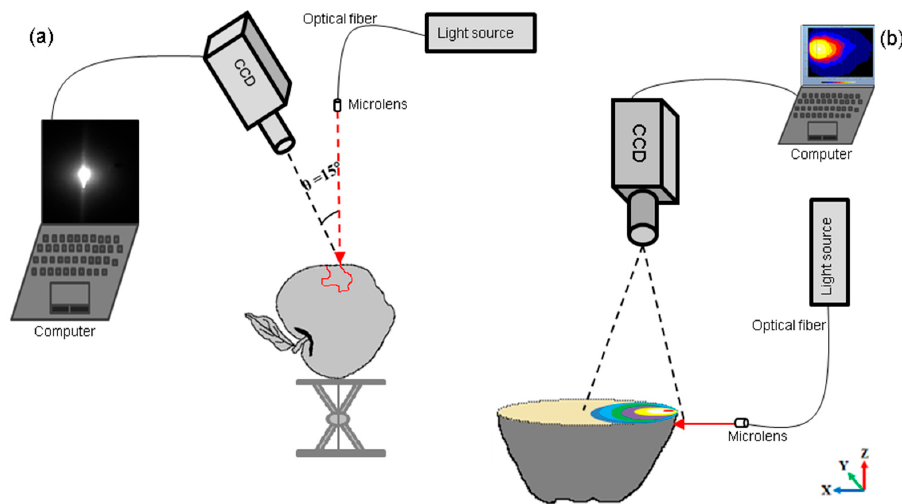
Figure 1. Experimental setup used for recording diffuse reflectance images from ( a ) a whole apple sample; and ( b ) a half-cut apple sample.